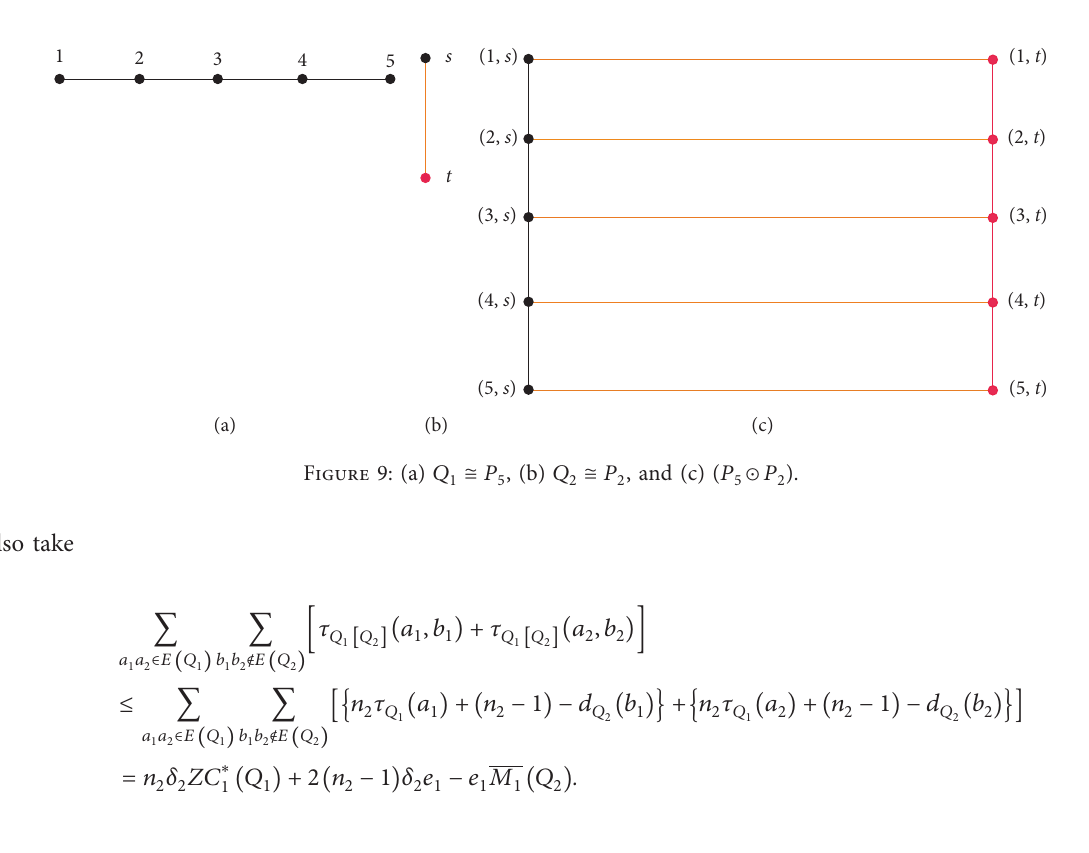
� N , and (c) cyclohexane ( C 2 2